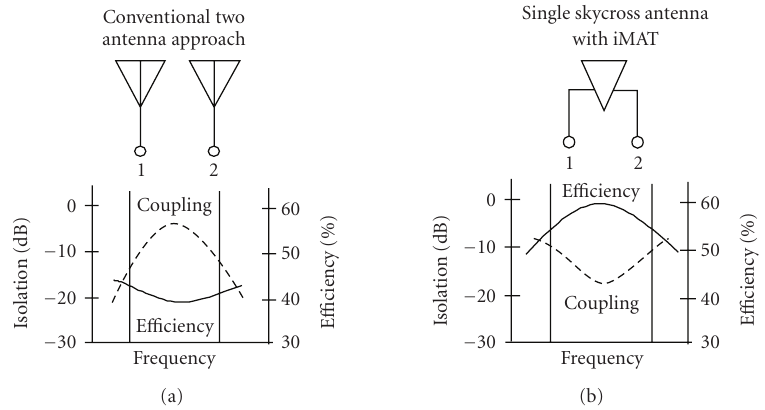
Figure 1: Illustration of a conventional antenna versus a two port iMAT antenna for MIMO application.